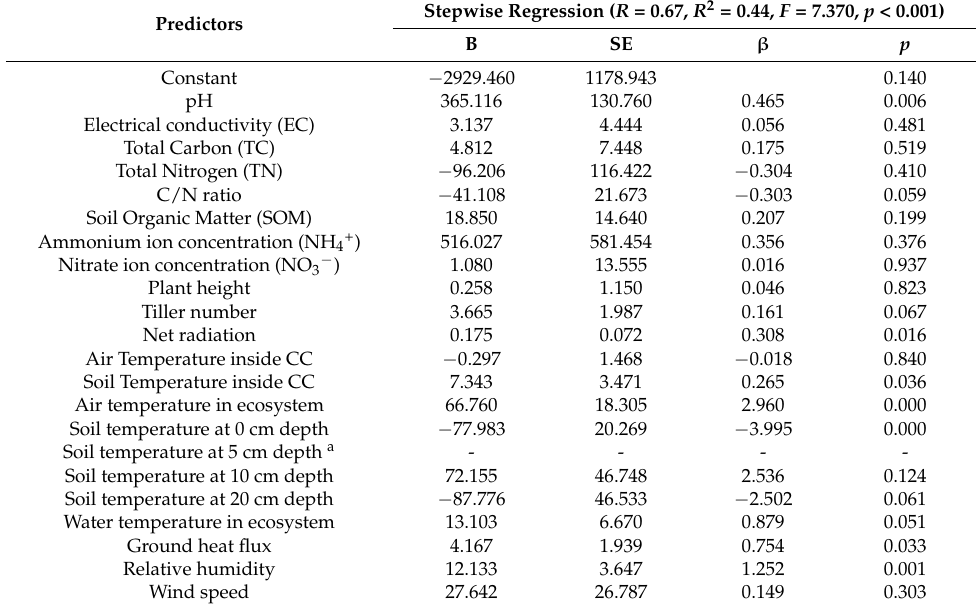
Table 2. Stepwise multiple regression analysis with environmental factors for surface CH 4 flux as measured using the CC method.